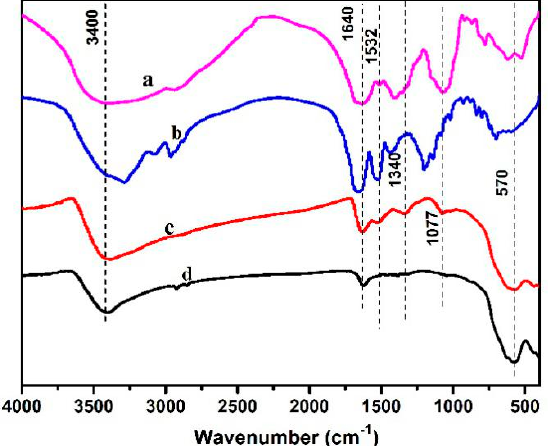
Figure 3. FT-IR spectra of ( a ) ginger extract, ( b ) peptide (QY), ( c ) Fe 3 O 4 -QY-G nanoparticles, Figure 3. FT ‐ IR spectra of ( a ) ginger extract, ( b ) peptide (QY), ( c ) Fe 3 O 4 ‐ QY ‐ G nanoparticles, ( d ) Fe 3 O 4 ( d ) Fe 3 O 4 nanoparticles. nanoparticles.